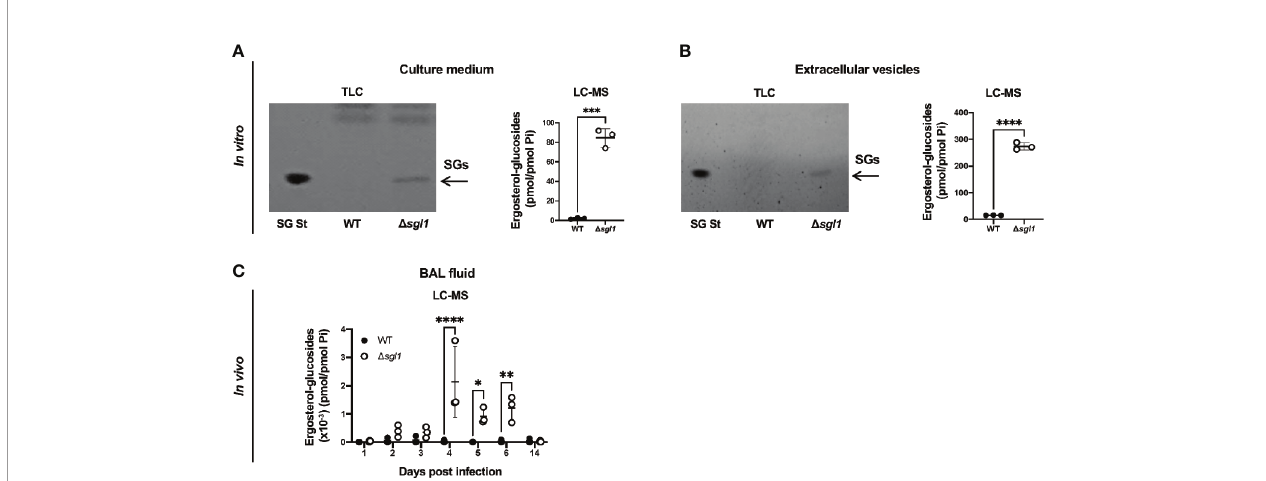
FIGURE 1 | Ergosterol-glucosides (SGs) can be detected both in vitro and in vivo with C neoformans ( Cn ) D sgl1 but not the WT strain. (A, B) In vitro analysis of the growth medium (A) or extracellular vesicles (B) for SGs from cultures of either Cn WT or D sgl1 was performed by TLC and LC-MS. (C) In vivo analysis of the bronchoalveolar (BAL) fl uid of CBA/J mice infected with either Cn WT or D sg / 1 for SGs was performed by LC-MS over the indicated timeline (n=3 mice/strain/ timepoint). Signi fi cance was determined by a two-tailed unpaired t-test (A, B) or a two-way ANOVA using S ̌ ı ́ da ́ k ’ s multiple comparisons test for P value adjustment (C) . Graphed data represents the mean +/- SD, and signi fi cance is denoted as * P < 0.05; ** P < 0.01; *** P < 0.005; **** P <